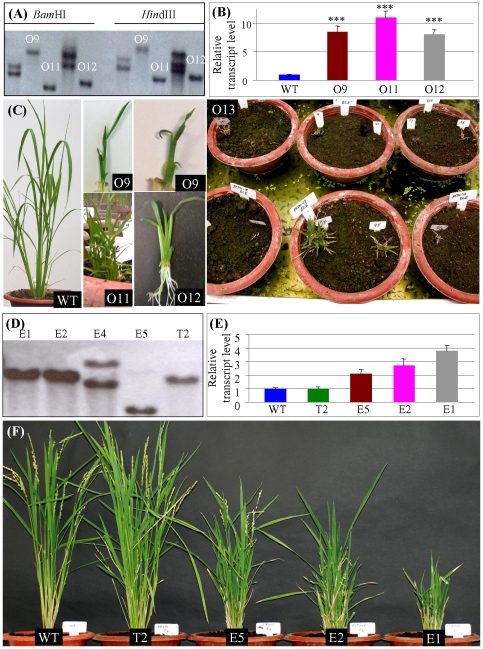
Phenotypic analysis of transgenic plants by over- and ectopic expressing OsCYP96B4.(A) Different patterns of T-DNA integration in transgenic plants harboring OsCYP96B4 driven by the maize ubiquitin promoter in WT (over-expression). (B) Bar diagrams showing the expression level of OsCYP96B4 in WT and three independent over-expression dwarf plants with single copy of T-DNA integration. The symbols “***” indicate significant differences in their expression level between WT and the transgenic plants at P<0.001 by t-test. (C) Phenotypic characterization of over-expression transgenic plants. O9, O11 and O12 showed severe dwarf phenotype in different transgenic plants. O13 shows that most of transgenic plants died after several months of growth. (D) Different patterns of T-DNA integration in transgenic plants harboring OsCYP96B4 driven by its own promoter in WT. (E) Bar diagrams showing the expression level of OsCYP96B4 in WT and three independent ectopic expression plants (E1, E2 and E4) as well as transgenic plants with the empty T-DNA integration (T2). The symbols “*”, “**” and “***” indicate significant differences in their expression level between WT and the transgenic plants at P<0.05, P<0.01 and P<0.001, respectively, by t-test. (F) Phenotypic characterization of ectopic expression transgenic plants by comparing with WT and T2 plants. In (A) and (D), the results are based on Southern blot hybridization.